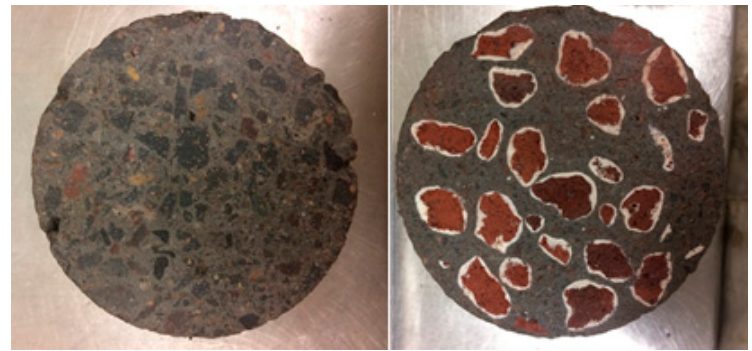
Figure 15. Cross section of control and TESA samples.